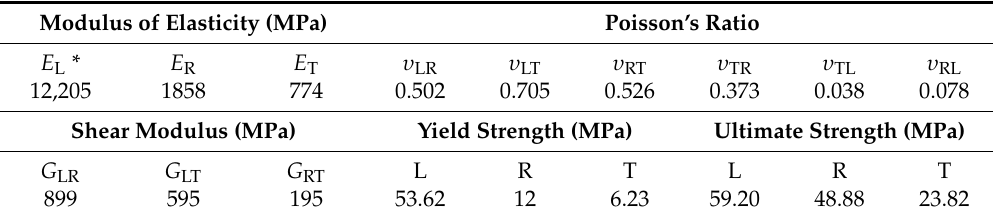
Table 1. Summary of mechanical properties of solid beech